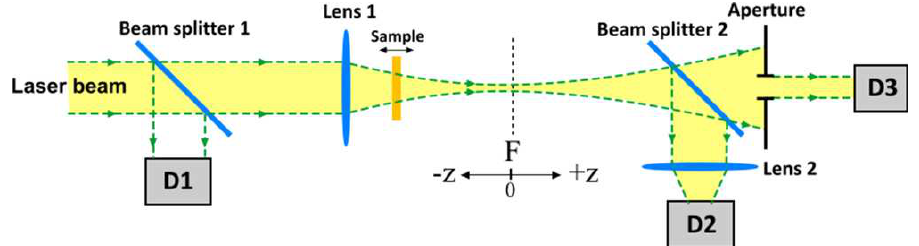
Figure 2. Scheme of the Z-scan setup, D1, D2, D3 are the